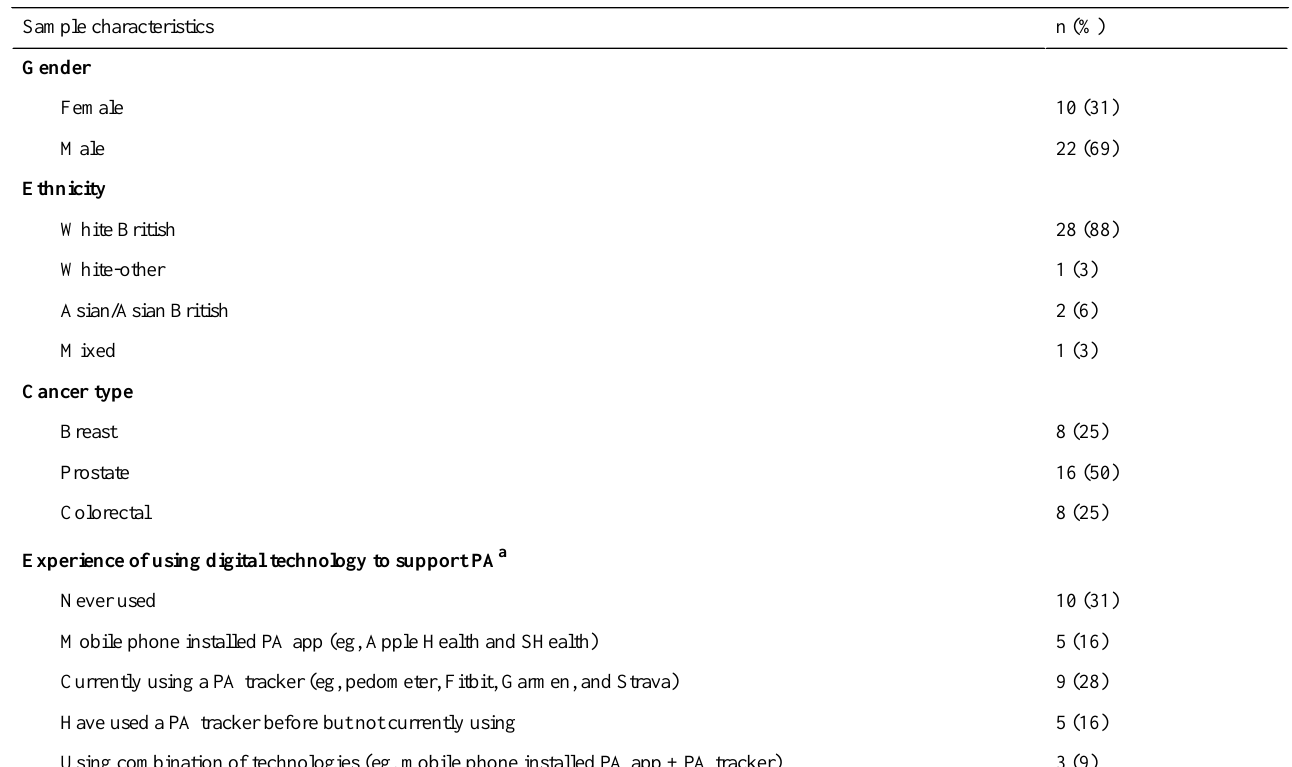
Table 3. Sample characteristics